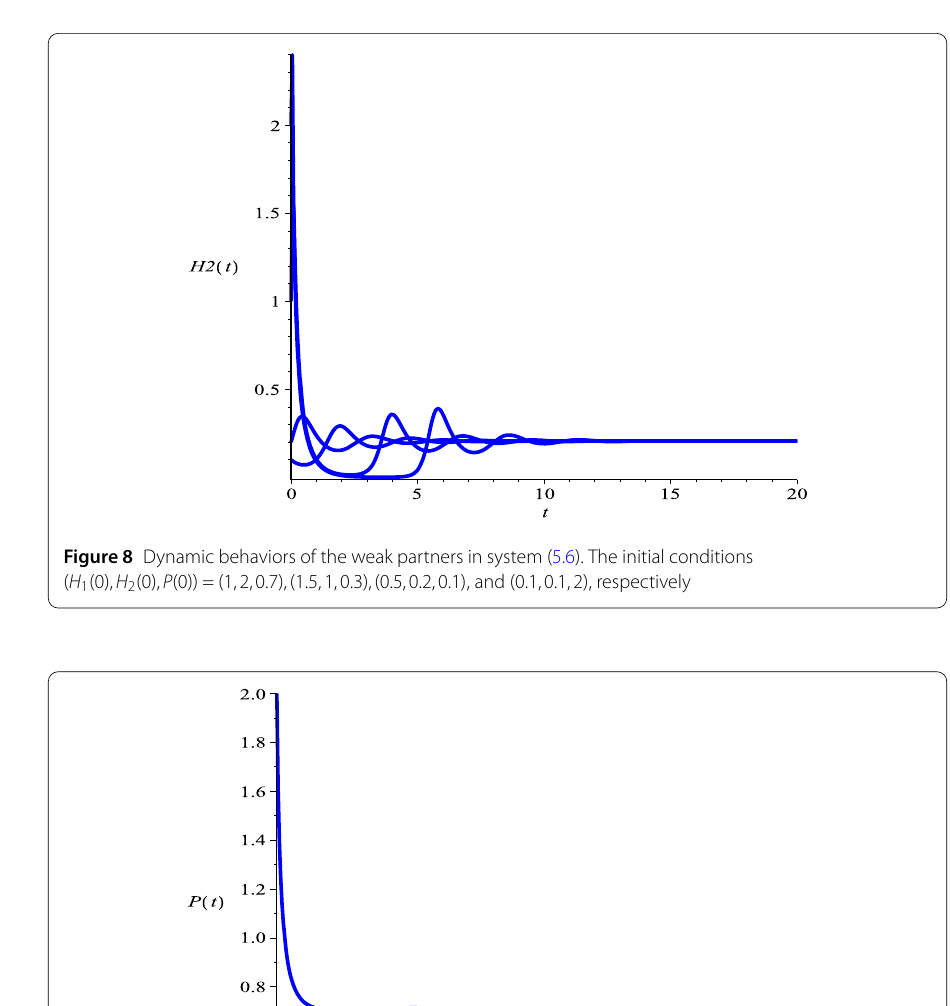
that in system (1.1), if the transform rate is too large, the strong partners will be driven to extinction; however, for model (1.3), numeric simulations (Figs. 7–9) show that in this